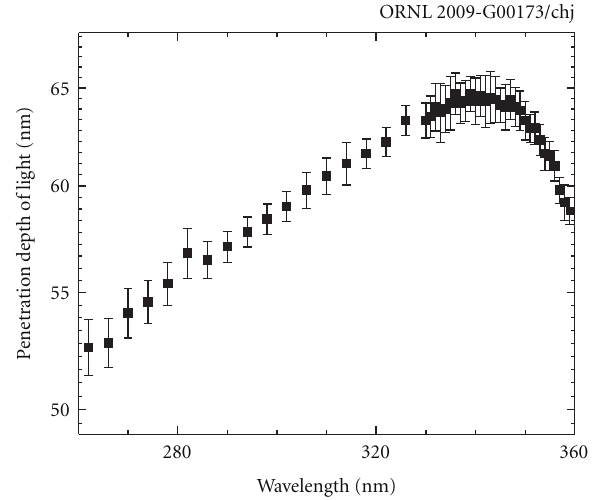
Figure 12: The optical penetration depth δ of light as a function of the wavelength for ZnO, where the optical absorption coe ffi cient α = 1 /δ . Data replotted from